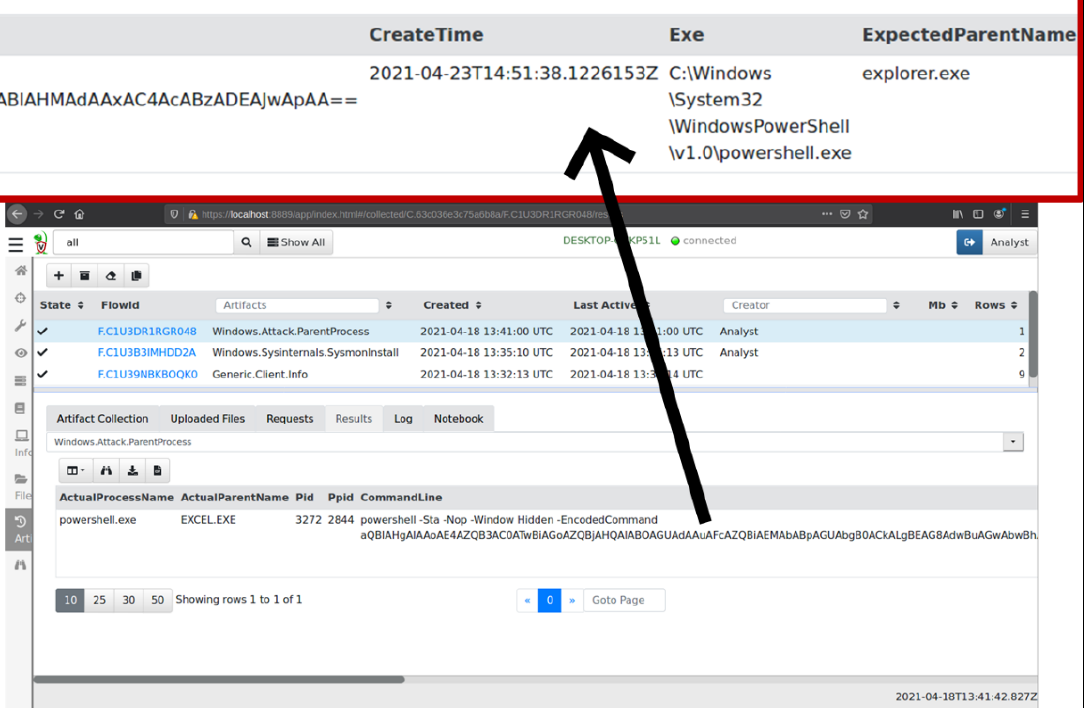
Figure 10. Malicious documents ’ parent process attack.